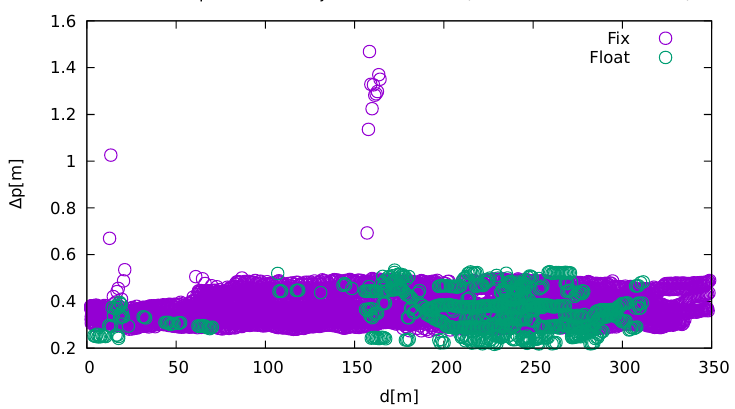
Figure 15. Position displacement for Leica GS15 using GPS and Galileo. Note a considerable discrepancy at a distance of 160 m from the jammer (own study, from the collection